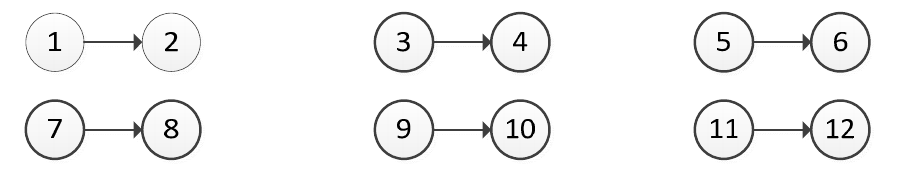
Figure 2. Graph Model of Changzhou Conflict for Movement by EPA.